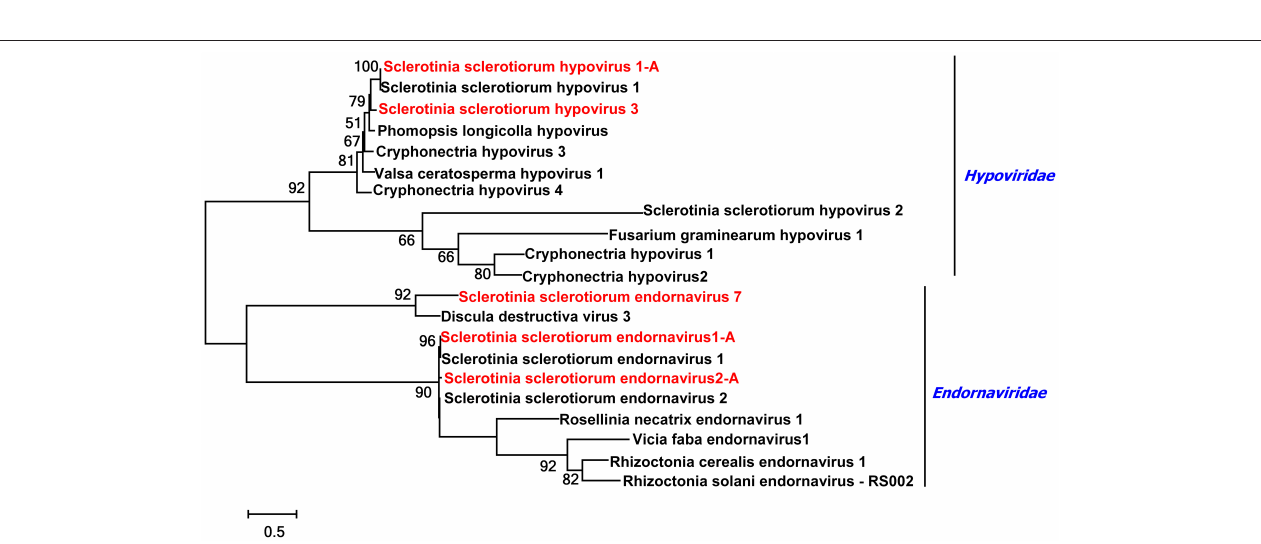
FIGURE 4 | Phylogenetic analysis of two unclassified viruses. Phylogenetic analysis of Sclerotinia sclerotiorum tetramycovirus-1 and Sclerotinia sclerotiorum botybirnavirus 3 with other selected viruses based on the RdRp protein amino acid sequences. Viruses marked with red color are found in Australian isolates of Sclerotinia sclerotiorum .